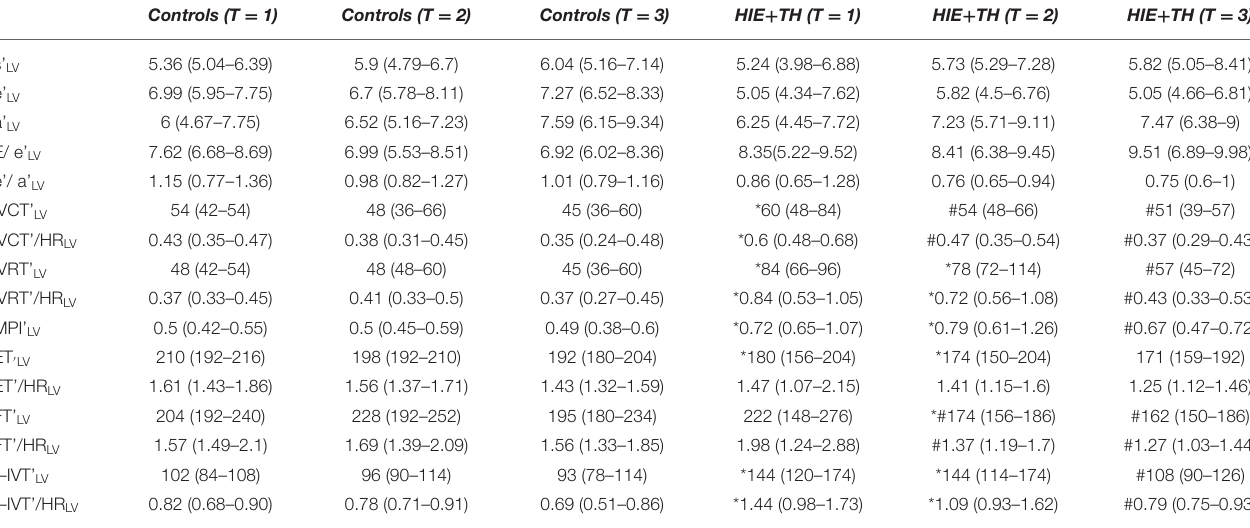
TABLE 3 | TDI data from the left ventricle.